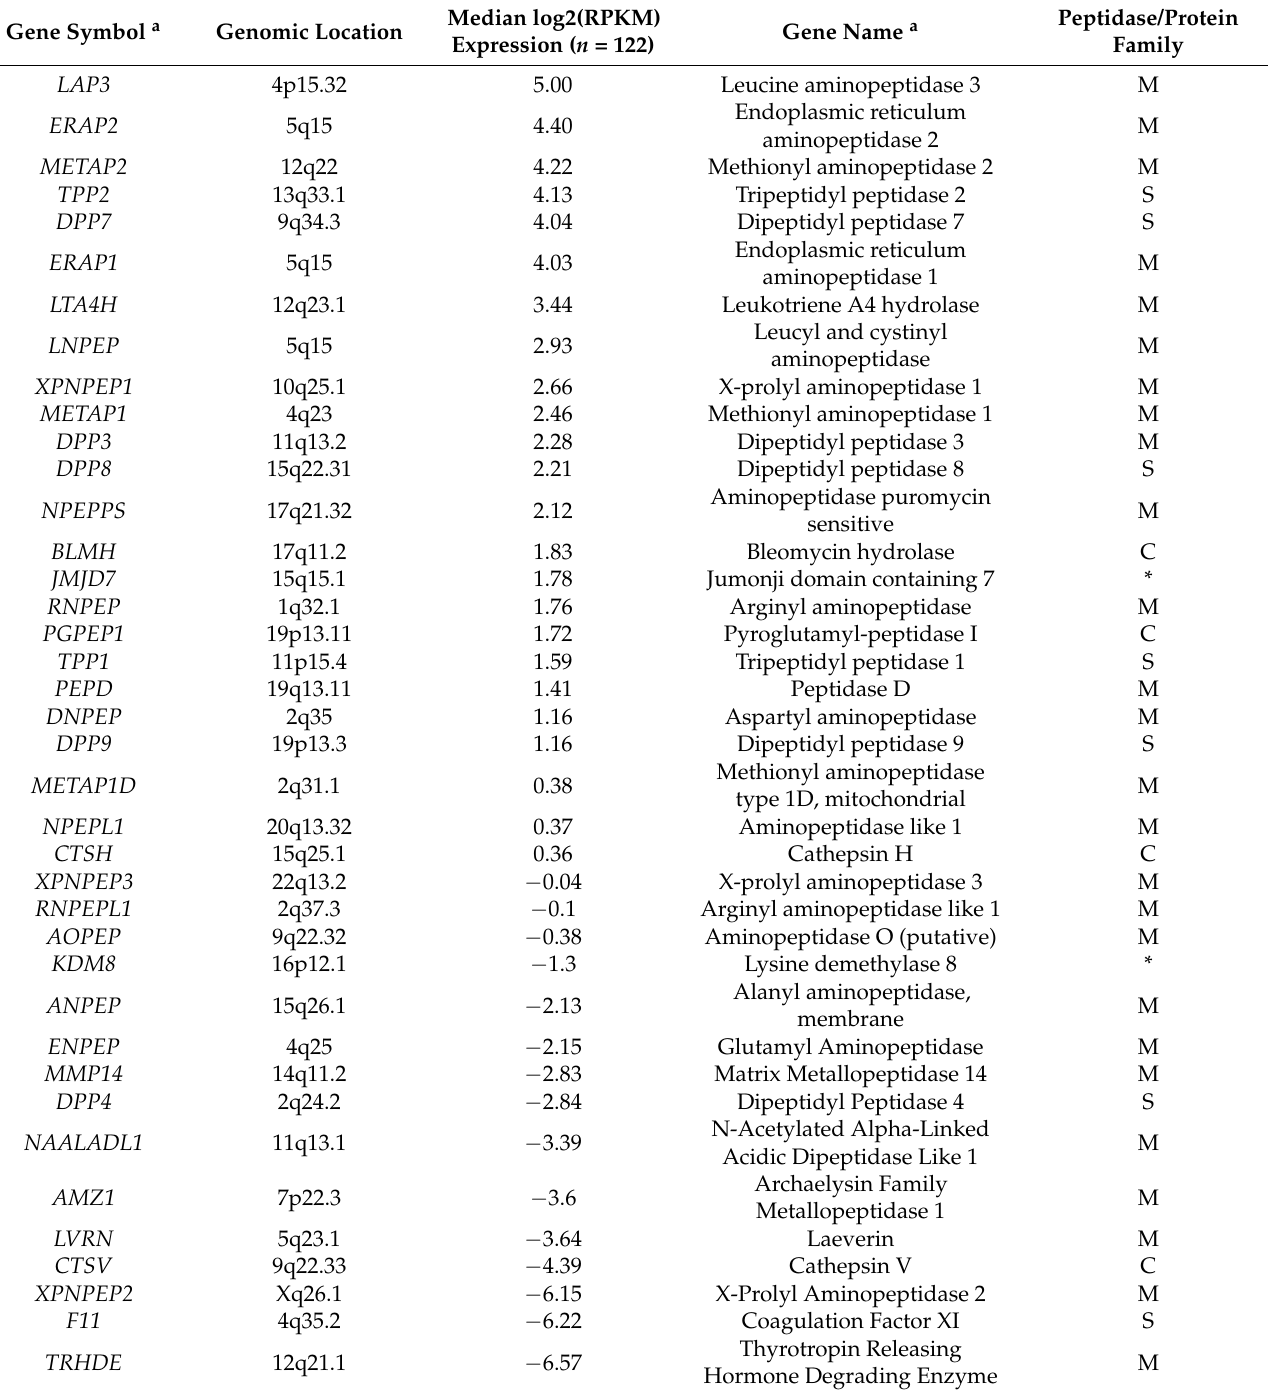
Table 2. List of evaluated aminopeptidase genes ( n = 39), sorted by median log2(RPKM) expression from RNAseq data from 122 multiple myeloma patient samples in the FIMM